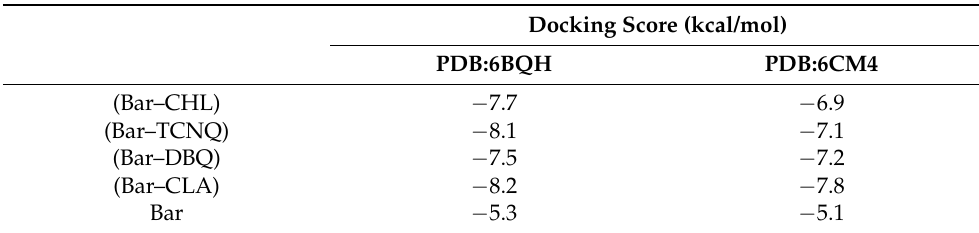
Table 2. Docking score of Bar and four synthesized CT complexes against serotonin (6BQH) and dopamine (6CM4).